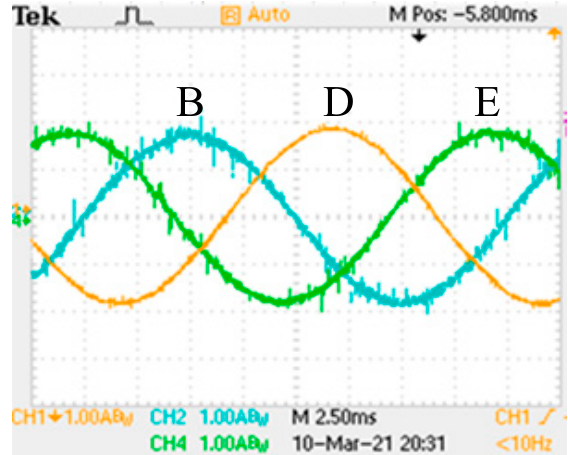
Figure 16. Lack of phase A and C fault − tolerant current waveform. As can be seen from the above figure, after the open − circuit fault of the five − phase motor, the residual phase current is no longer balanced. After fault − tolerant control, the residual phase current is balanced and the motor can work normally. The comparison with a theoretical analysis and simulation verifies the effectiveness of the fault − tolerant control strategy in this paper. The change in motor speed after an open − circuit fault and fault − tolerant control is measured in the experiment, as shown in Tables 3–5. Table 3. Motor speed changes after open − circuit fault of phase A and fault − tolerant control. Input Voltage (V) Normal Operation (r/min) 1470 Table 4. Motor speed changes after open − circuit fault of phase AB and fault − tolerant control. Input Voltage (V)